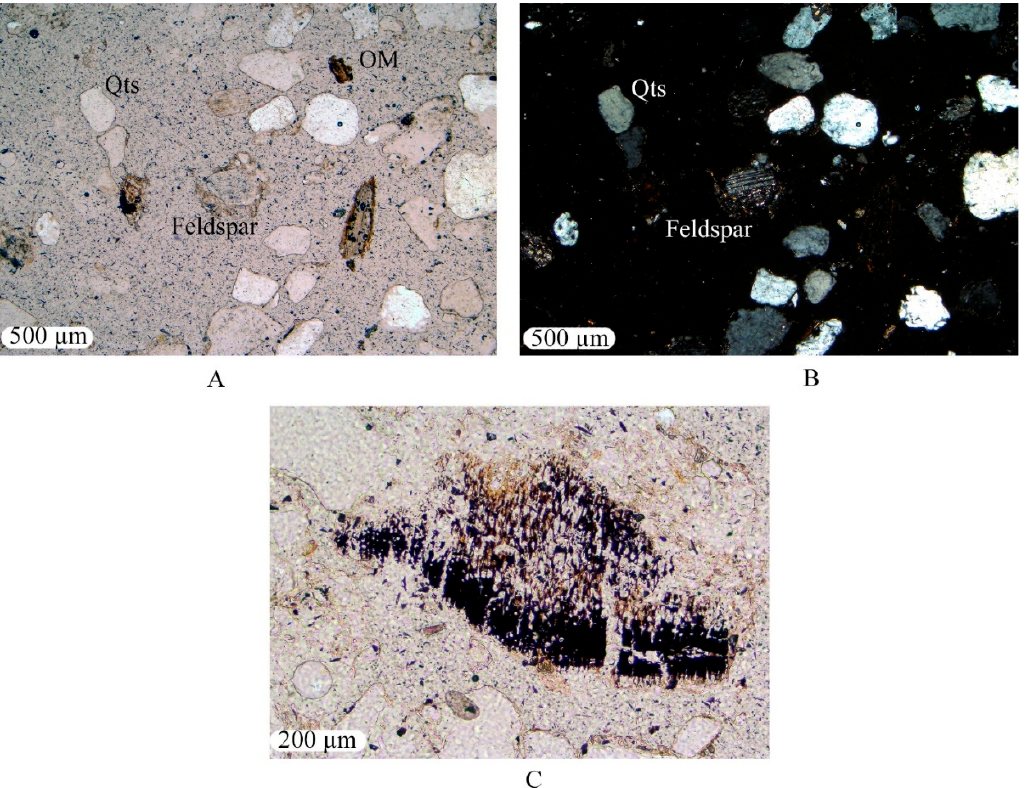
Figure 4. Micromorphological structure of the Y5 Ah horizon. ( A , C )—Plane polarized light; ( B ) crossed polarized light.